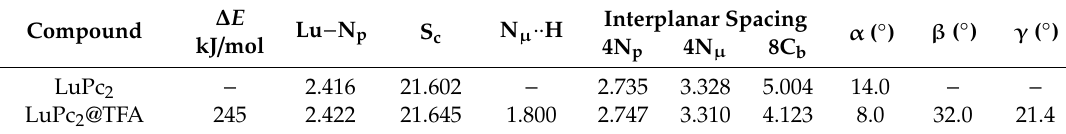
Table 3. Selected molecular data for the base LuPc 2 complex and its LuPc 2 @TFA conjugate; Δ E —total